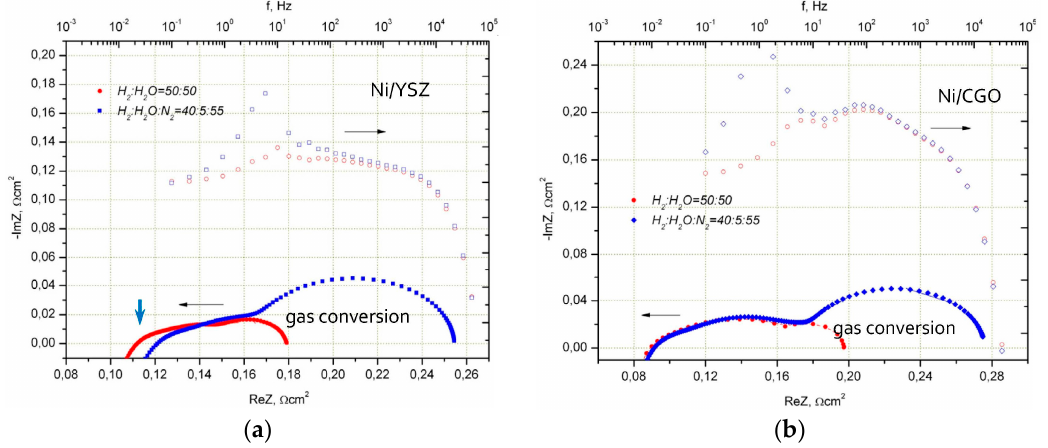
Figure 3. Impedance spectra of MEAs with the LSMM’/10Sc1CeSZ air electrode and the Ni/YSZ ( a ) and Ni/CGO ( b ) fuel electrode at 850 °C with air as oxidant in fuel with different steam content. On the contrary, Ni/CGO fuel electrode impedance stays constant even in fuel with lower steam content. In both electrodes at a steam content of 5%, similar gas conversion impedance at low frequencies was observed.